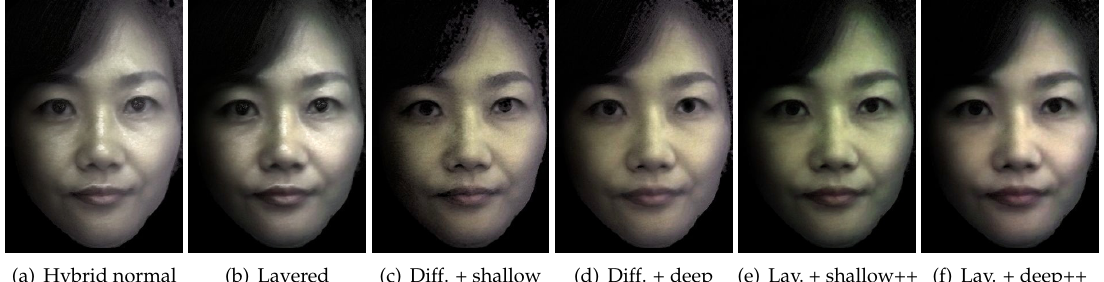
Figure 12. Hybrid normal renderings and editing applications of layered reflectance and normals with data acquired using four photographs under polarized spherical gradient illumination. ( a ) Rendering with separate diffuse and specular normals as proposed by Ma et al. [27]. ( b ) Layered hybrid normal rendering with diffuse reflectance further separated into shallow and deep albedo and normals. ( c , d ) Diffuse rendering using shallow scattering normal ( c ) and deep scattering normal ( d ), respectively, for shading the diffuse albedo. ( e , f ) Layered hybrid normal rendering with relative enhancement of the shallow scattering albedo ( e ) and relative enhancement of the deep scattering albedo ( f ),